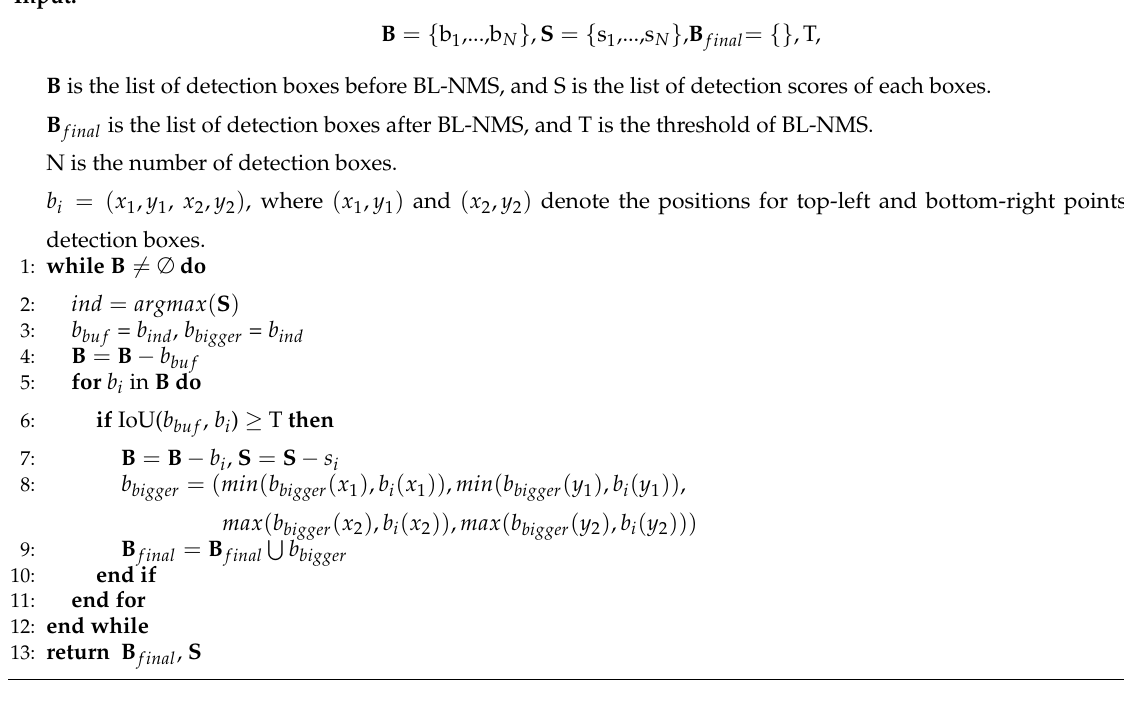
Algorithm 1 Bigger-Left Non-Maximum Suppression